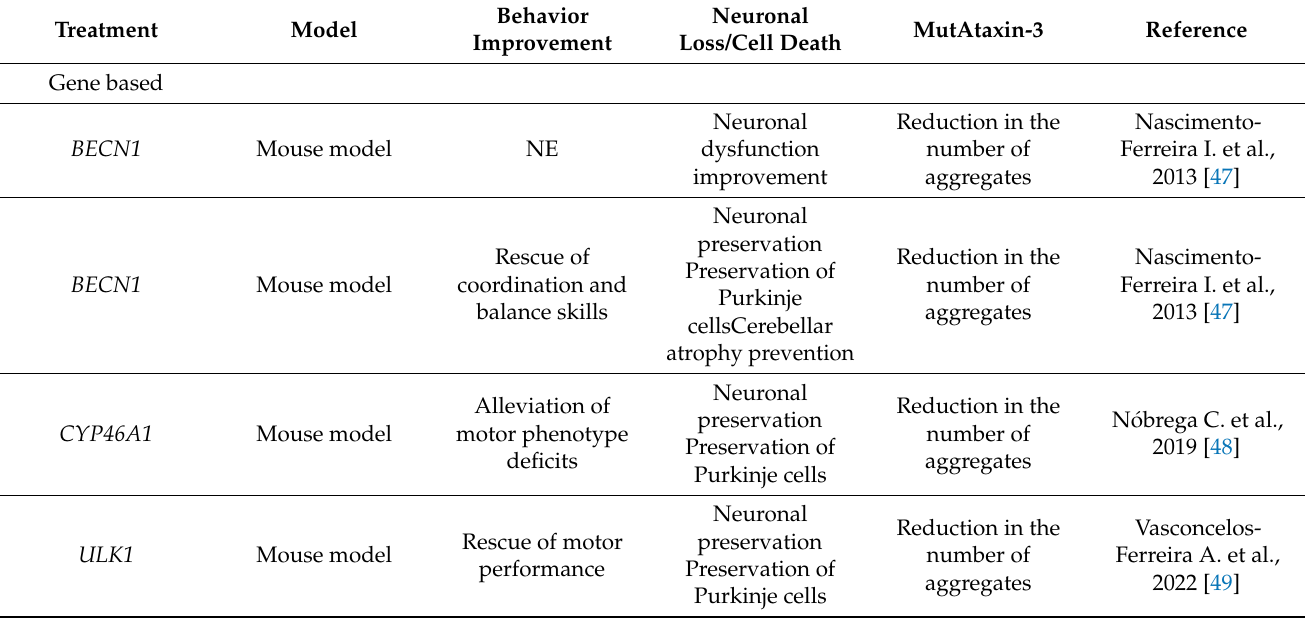
Table 5. Overview of the main outcomes of the gene-based strategies used to induce autophagy in MJD/SCA3 mouse